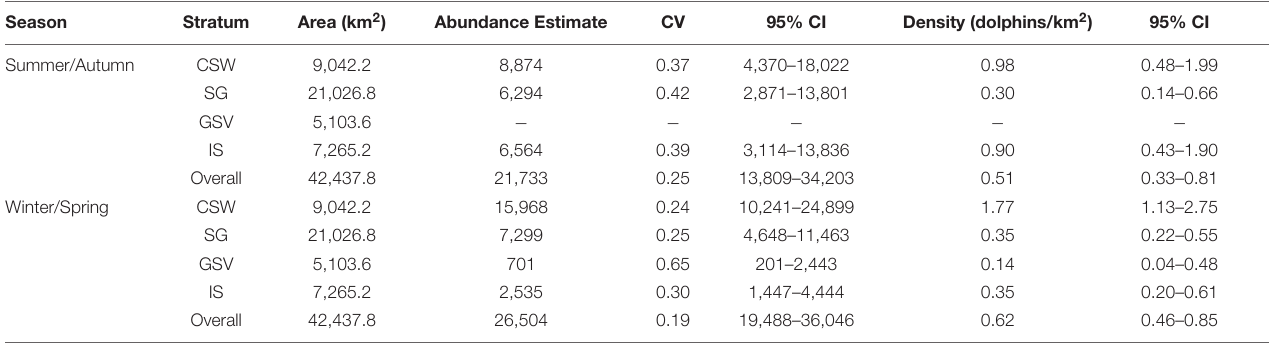
TABLE 3 | Estimates of abundance and density of common dolphins ( Delphinus delphis ) from the 2011 summer/autumn and winter/spring aerial surveys in central South Australia.